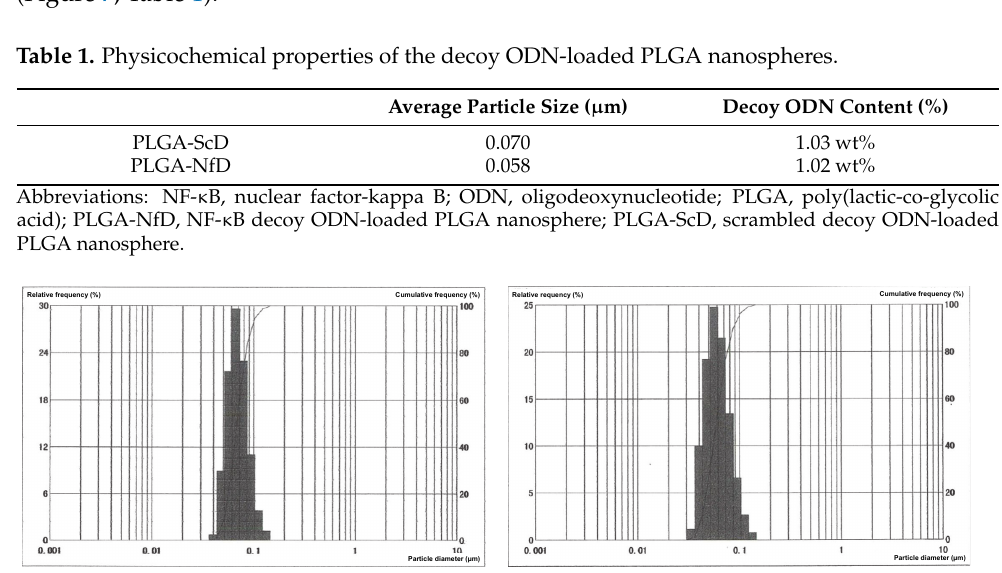
Figure 7. Particle size distribution of the PLGA-NfD ( left ) and PLGA-ScD ( right ) nanospheres evaluated by DLS method. The histogram indicates the relative frequency and the black line represents the cumulative distribution frequency as the particle count-basis.